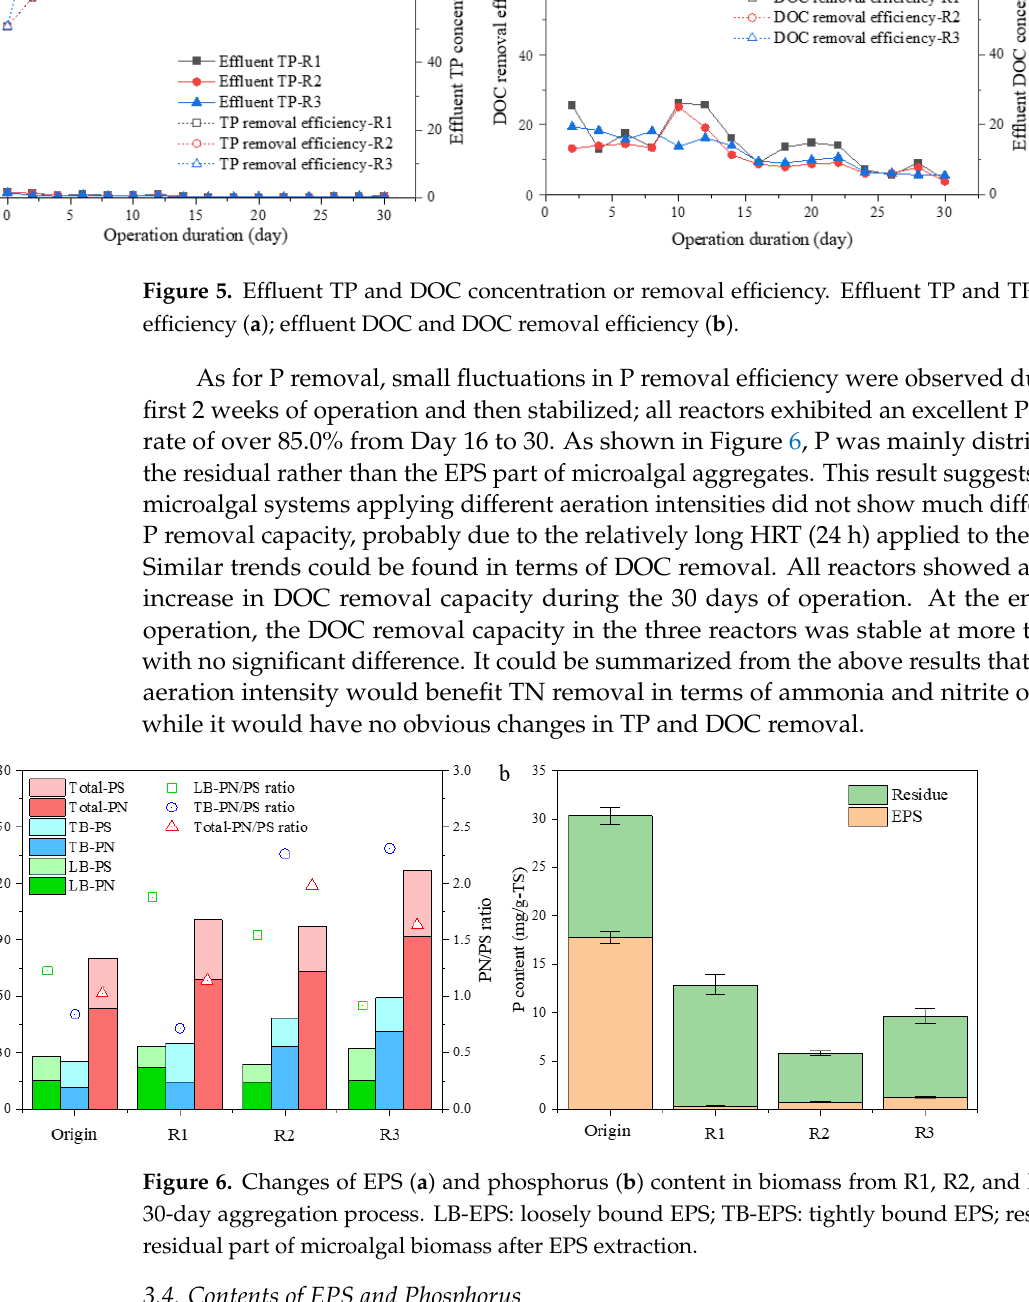
Figure 4. Effluent nitrogen concentrations and TN removal efficiency. Effluent TN and TN removal efficiency ( a ), effluent ammonia nitrogen (NH 4+ − N) ( b ), effluent nitrate nitrogen (NO 3 − − N) ( c ), and effluent nitrite nitrogen (NO 2 − − N) ( d ) concentrations.